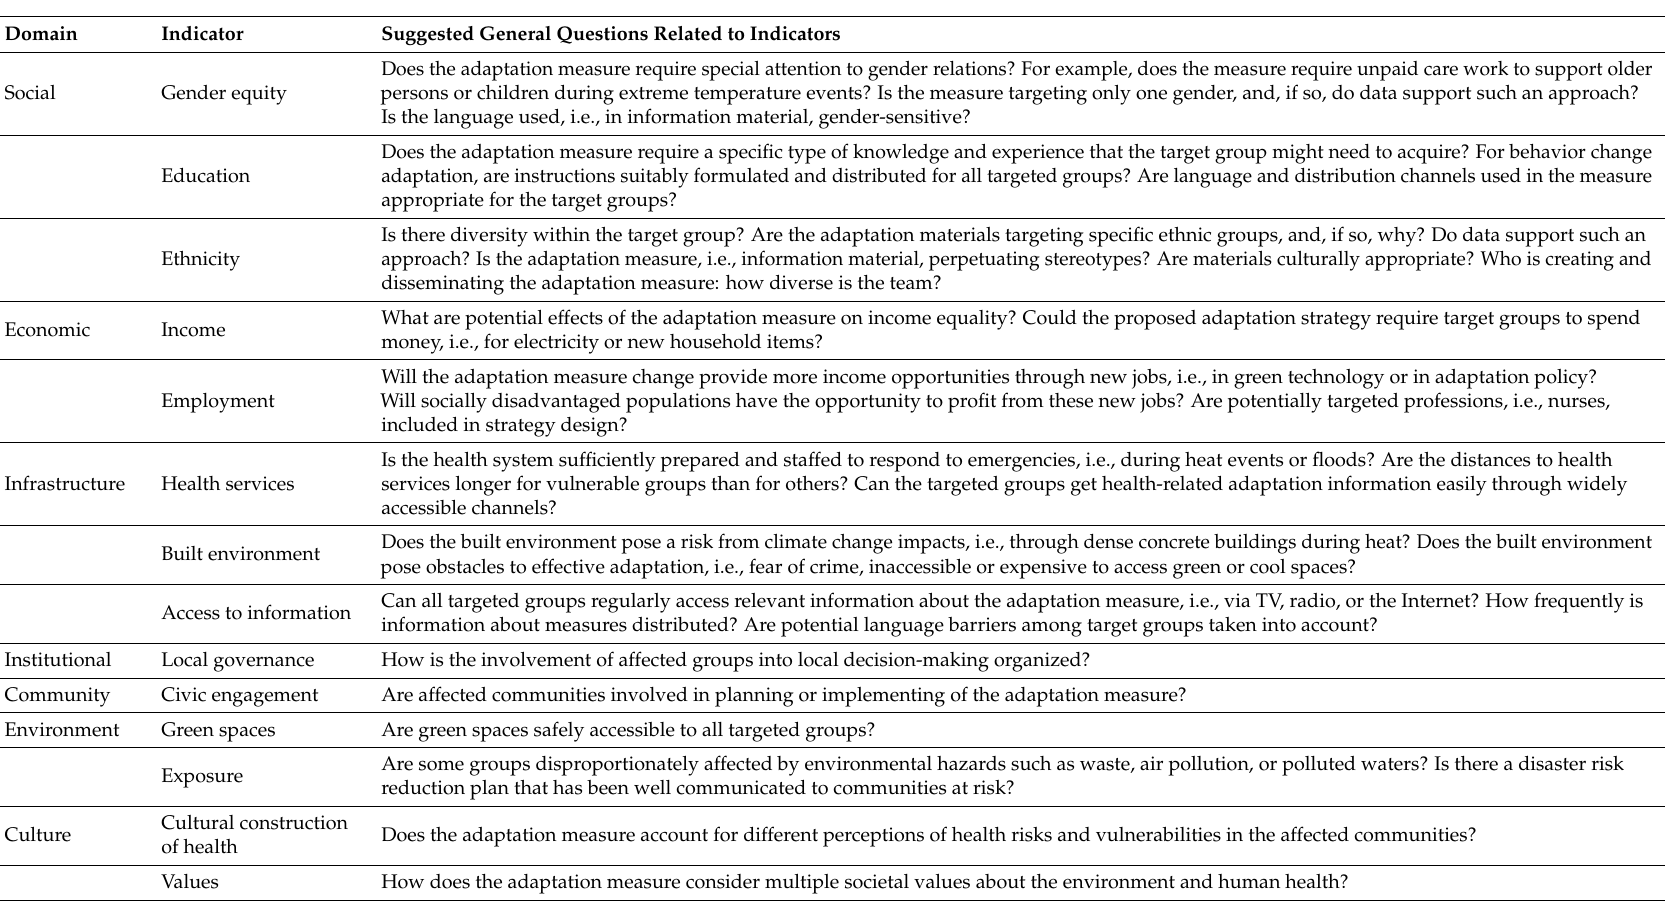
Table 2. Guiding questions to conceptualize the framework indicators (example